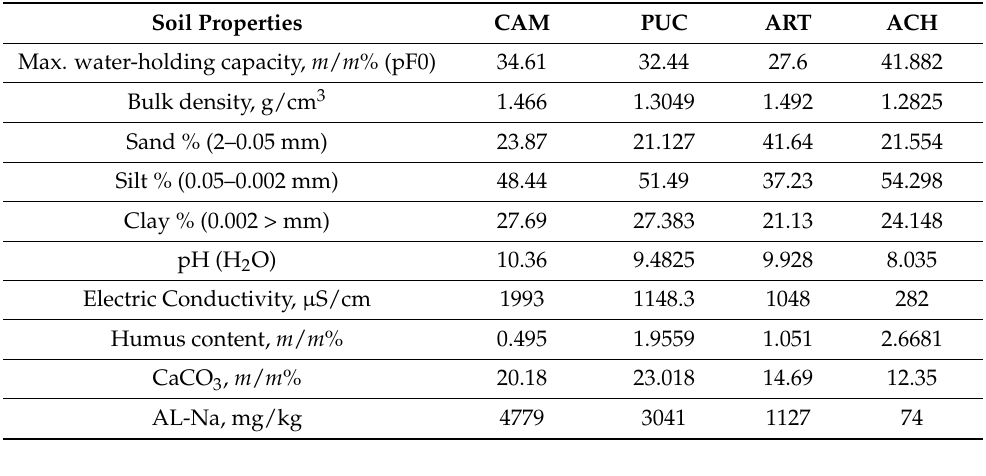
Table 2. Average values of soil physico-chemical properties of the four studied salt-affected habitats in Apajpuszta, Hungary ( n = 4). CAM = annual open salt sward, PUC = Pannonic Puccinellia limosa hollow, ART = Artemisia saline puszta, ACH = grassy saline puszta.